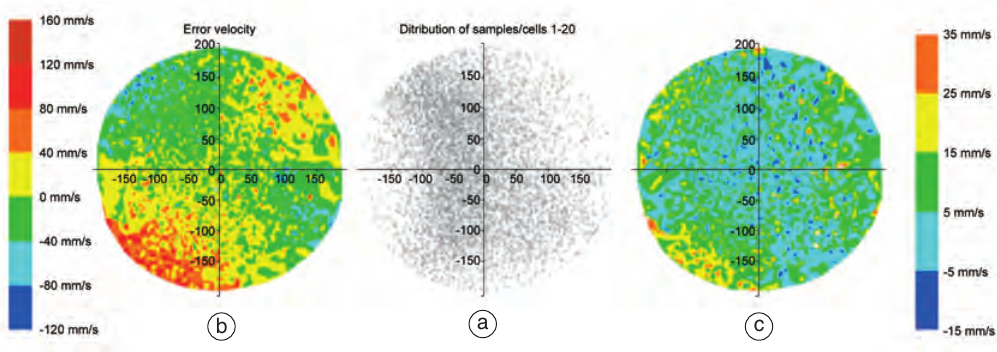
Fig. 12a-c. a) Distribution of samples for cells #1-20 as a function of the current direction and speed up to 200 mm/s (north is upward). b) Distribution of the error velocity (scale on the left) for cells #1-20 versus current